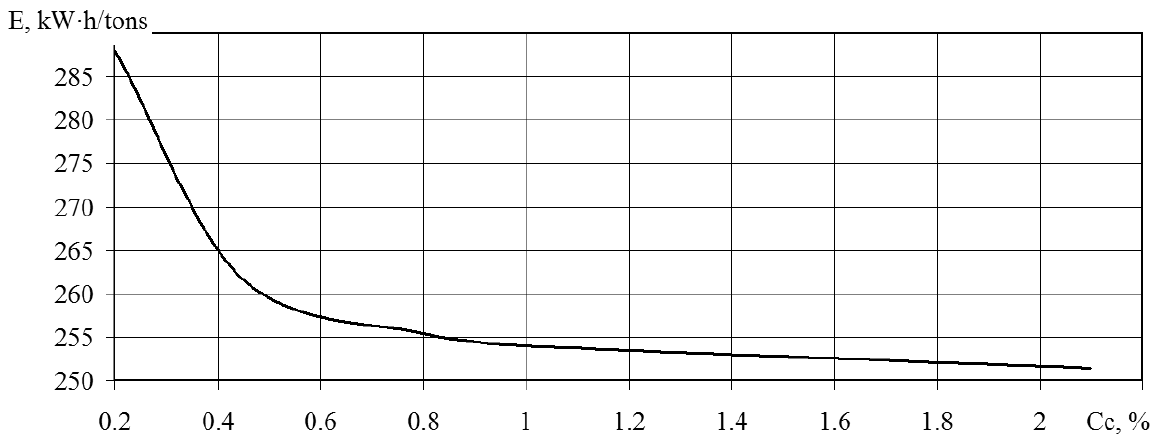
Fig. 4. The effect of increasing the carbon content in the auger material on reducing the growth rate of energy consumption of the dehydration process MSW after its two-week operation and wear ( s = 56850